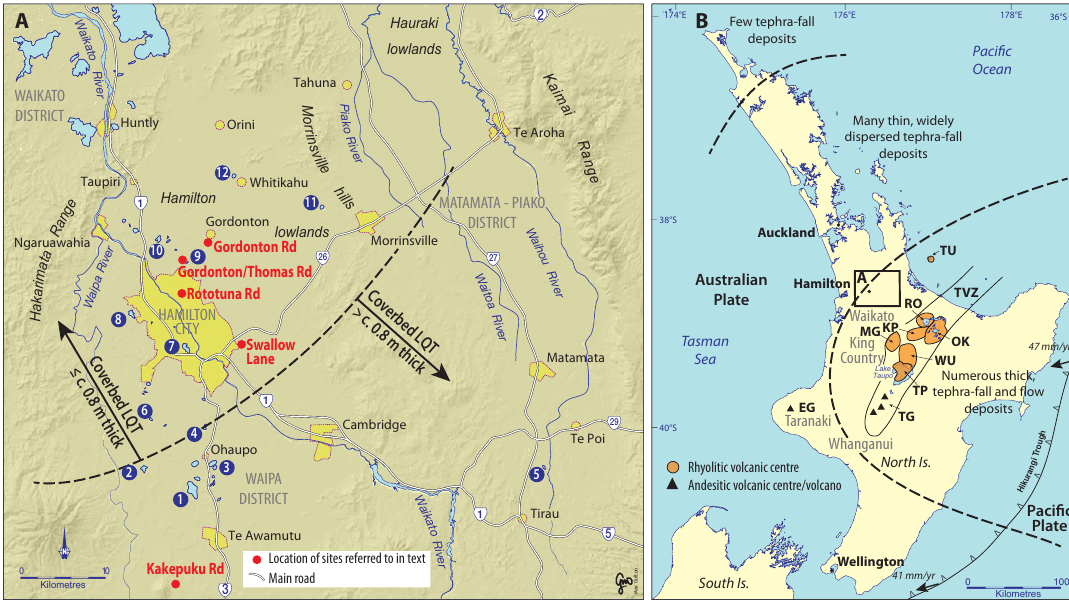
Figure 1. ( A ) Map of the central Waikato region, northern North Island, showing the locations of sites illustrating the Kainui soil and its associated stratigraphy and buried paleosols in the Hamilton lowlands. Some physiographic features are shown and local authority districts are also named. The dashed line marks the approximate boundary, c. 0.8 m, of the total thickness of the coverbed mantle of late Quaternary tephras (LQT), based on [35] (pp. 35–36). It marks an Andisol–Ultisol threshold, with Andisols generally formed to the south and Ultisols to the north. Late Quaternary lakes that have been cored, and which contain a record of rhyolitic and andesitic tephra deposition in the region since c. 22–20 ka [18,36,37], are numbered as follows: 1, Ng¯aroto; 2, Mangakaware; 3, Rotomanuka; 4, Maratoto; 5, Okoroire; 6, Mangahia; 7, Rotoroa; 8, Rotokauri; 9, Tunawhakapeke (drained); 10, Kainui; 11, Leesons; 12, Rotokaraka. ( B ) Map of North Island, New Zealand, showing its general plate tectonic setting and all but two of the rhyolite volcanic centres (calderas) active in the Quaternary in the central Taup¯o Volcanic Zone (TVZ): OK, Okataina; RO, Rotorua; KP, Kapenga; MG, Mangakino; WU, Whakamaru; TP, Taup¯o. Offshore Tuhua Volcanic Centre (TU) (Mayor Island) and andesitic volcanoes at Tongariro Volcanic Centre (TG) and Egmont volcano (EG) (Mt Taranaki) are also shown (after [38]). Some regions are named and a generalized thickness pattern of soil-forming tephra deposits is depicted in three broad zones reflecting proximity to source volcanoes and the influence of prevailing westerlies (after